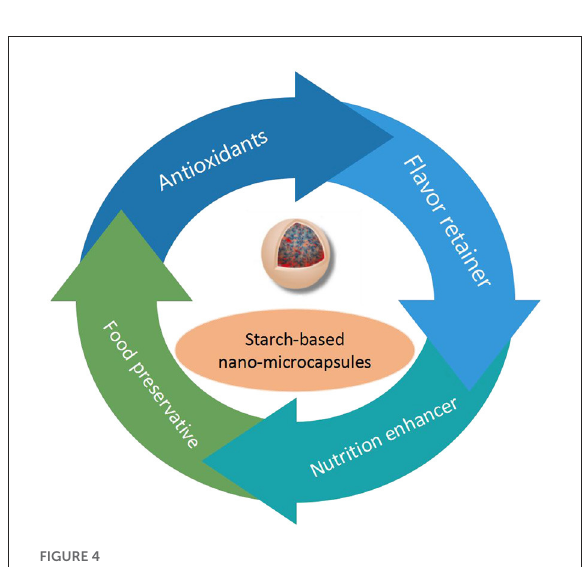
FIGURE4 Application of starch-based nano-microcapsules in functional